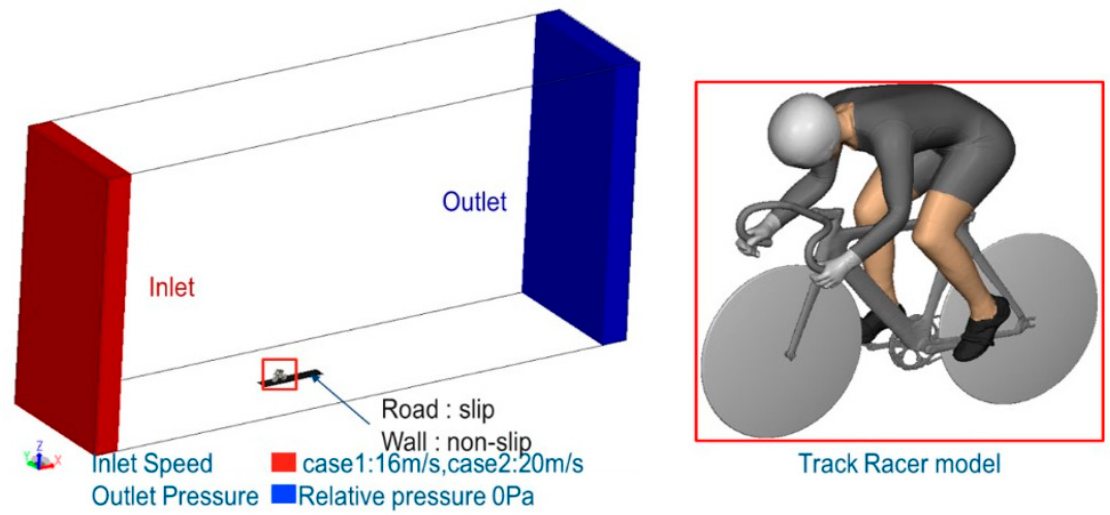
Figure 4. Calculation area boundary conditions and the 3-D model.